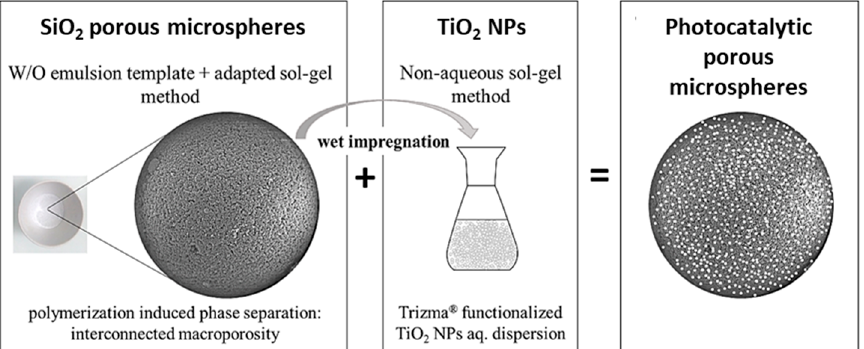
Figure 32. Methodology for preparing the photocatalytic porous microspheres: SiO 2 microspheres loaded with TiO 2 (anatase) NPs. Reprinted from the open access paper by A.C. Marques, M. Vale, D. Vicente, M. Schreck, E. Tervoort, M. Niederberger, “Porous Silica Microspheres with Immobilized